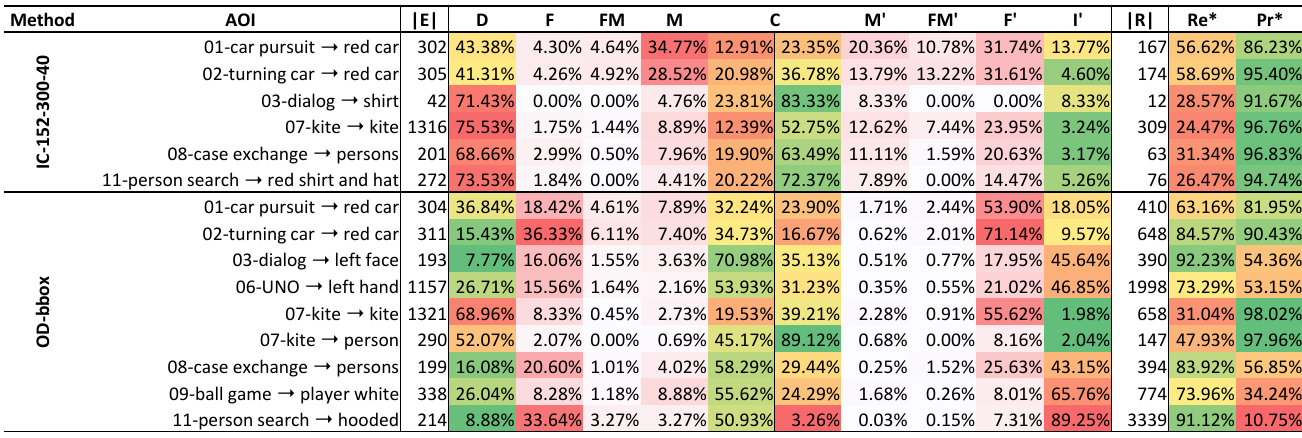
Figure 5. EAD table for AOIs with a non-zero recall ( dr < 90%; D